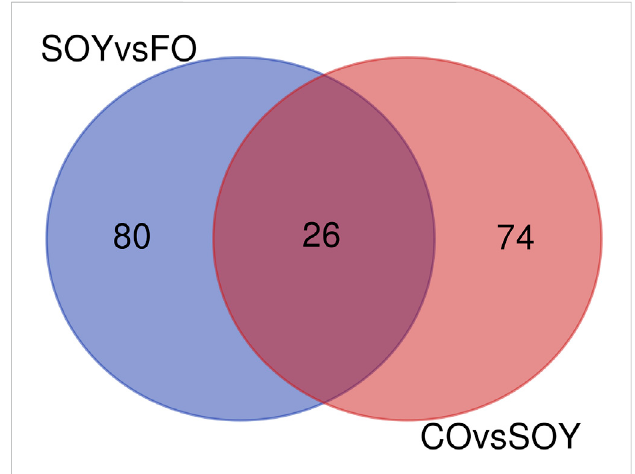
FIGURE 1 Venn diagram of the comparison of 3.0% soybean oil vs . 3.0% fi sh oil (SOY vs . FO) and 3.0% canola oil vs. soybean oil (CO vs. SOY).